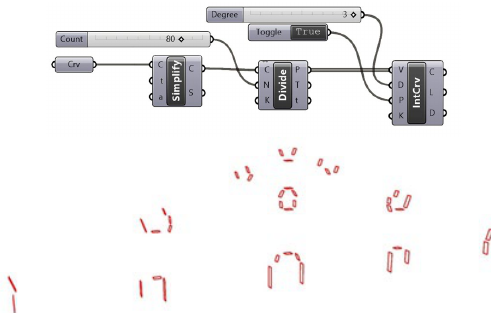
Figure 5: Automatic generation of cross-sections